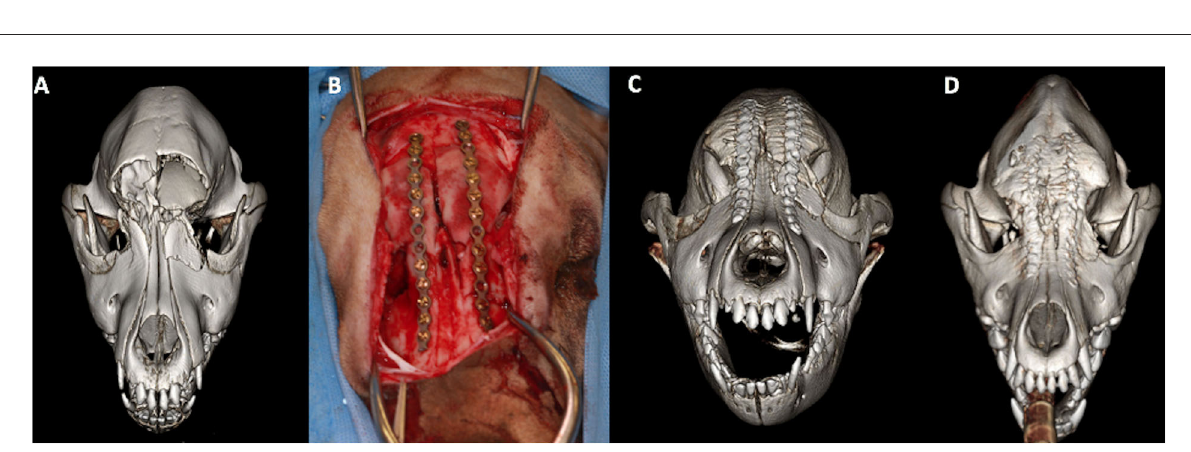
FIGURE2 3D-rendered CBCT images (A,C,D) and intraoperative image (B) of the skull of a 4-month-old golden retriever dog. The preoperative scan (A) demonstrates complete and severe displaced fractures of the frontal bones, complete and mildly displaced fracture of the maxillary and lacrimal bones. Open reduction and internal fixation (B) using 2.0-mm non-locking titanium plates and screws was performed. The postoperative scan (C) demonstrates adequate reduction and apposition of the fracture fragments. The 6-month postoperative CBCT scan (D) reveals excellent bone healing without the interference of growth and development of the pediatric facial